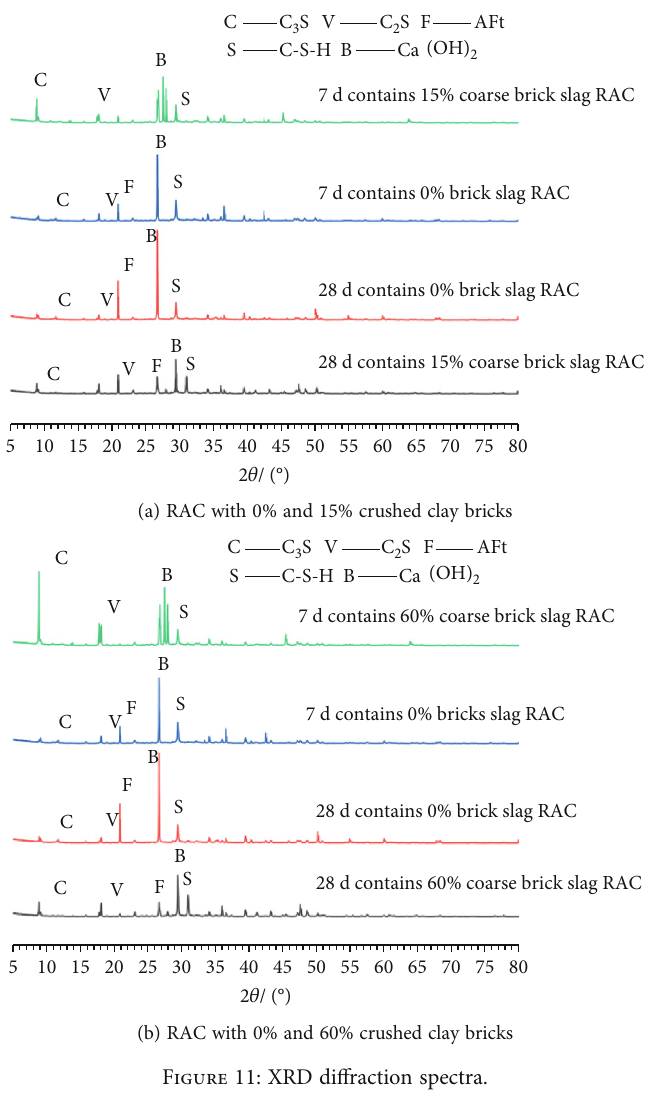
Figure 11: XRD di ff raction